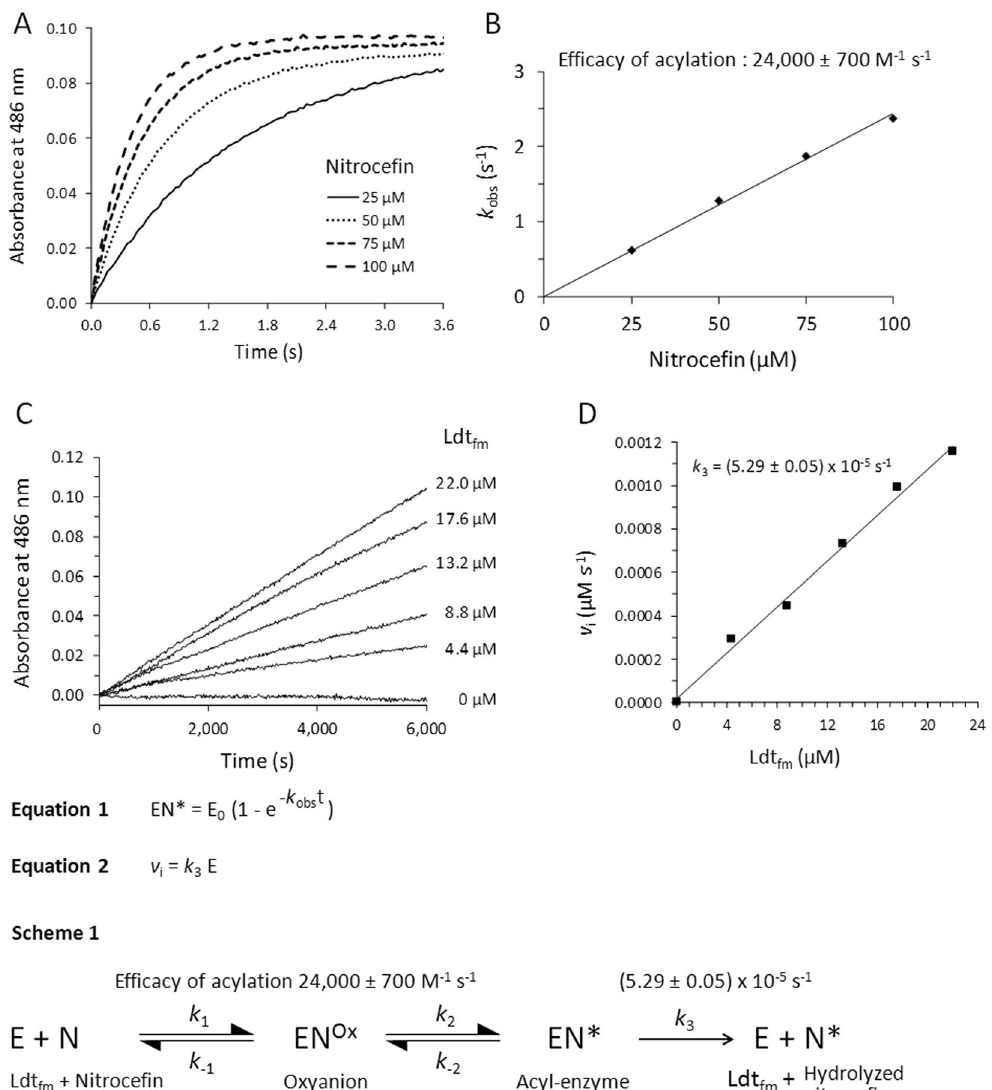
Figure 3. Kinetics of Ldt fm acylation by nitrocefin and of hydrolysis of the resulting acyl-enzyme. ( A) Stopped- flow kinetics of acylation of Ldt fm (11 µ M) by nitrocefin (25, 50, 75, and 100 µ M) in 100 mM sodium phosphate buffer (pH 6.0) at 20 °C. The value of k obs was determined by fitting Equation 1 to data. E 0 , concentration of native Ldt fm at t = 0. ( B) Variation of k obs as a function of the concentration of nitrocefin. ( C) Hydrolysis of a fixed concentration of nitrocefin (50 µ M) by Ldt fm at various concentrations (0 to 22 µ M). ( D) The initial rate of hydrolysis ( v i ) was plotted as a function of the concentration of Ldt fm and the value of k 3 was determined by linear regression (Equation 2) considering that Ldt fm is fully acylated under these